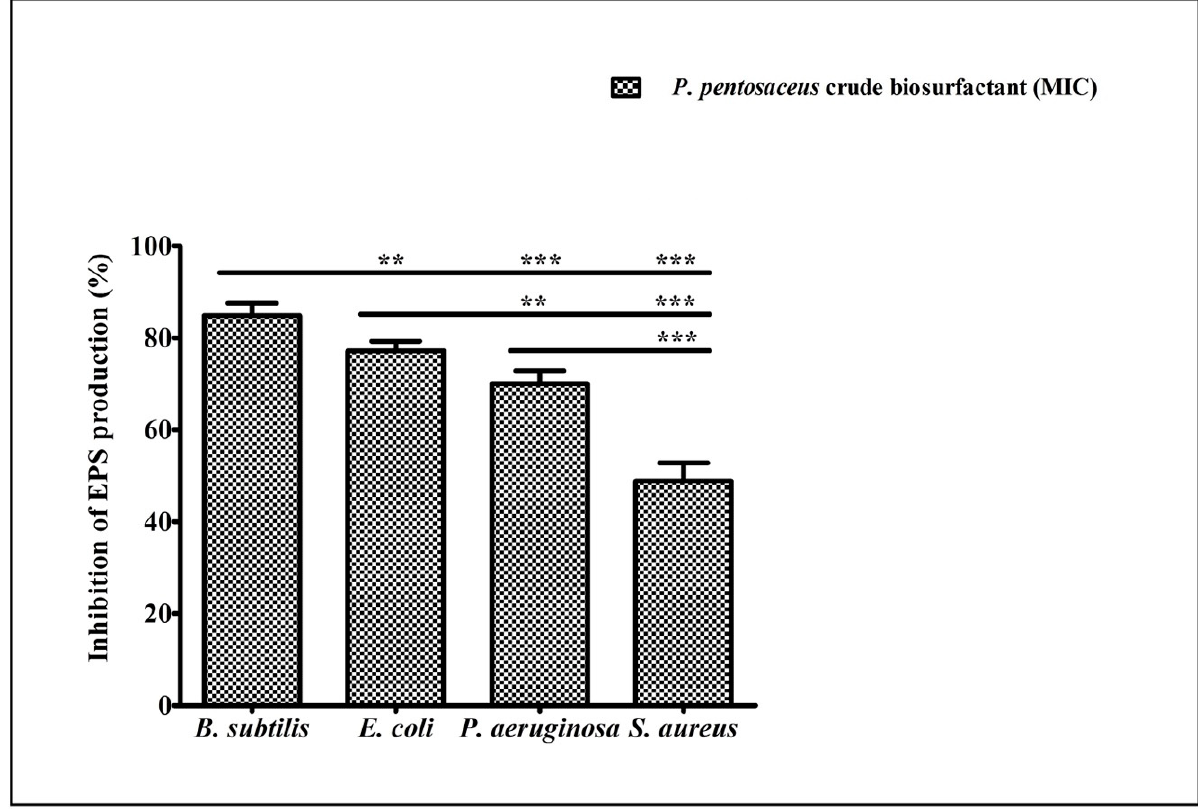
Figure 6. Inhibition of total EPS production by test pathogens in the presence of the P. pentosaceus crude biosurfactant at their respective MICs. Values are represented as mean ± SD of three independent experiments. Significance; ns > 0.05, * p < 0.05, ** p < 0.005, *** p < 0.0005.